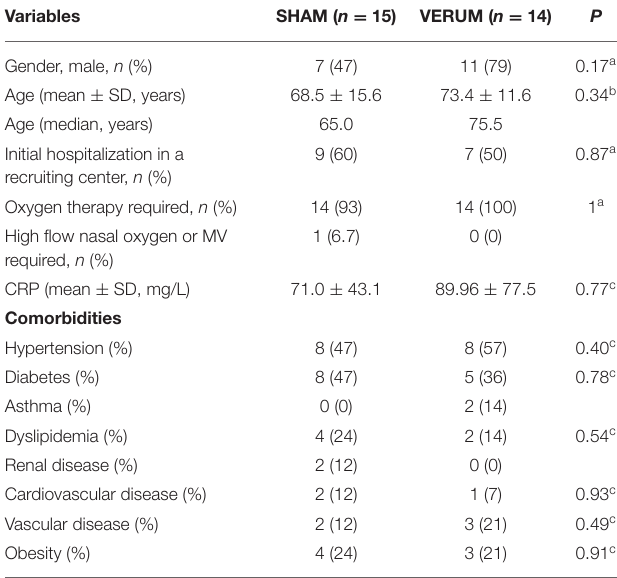
TABLE 1 | Characteristics of study patients at